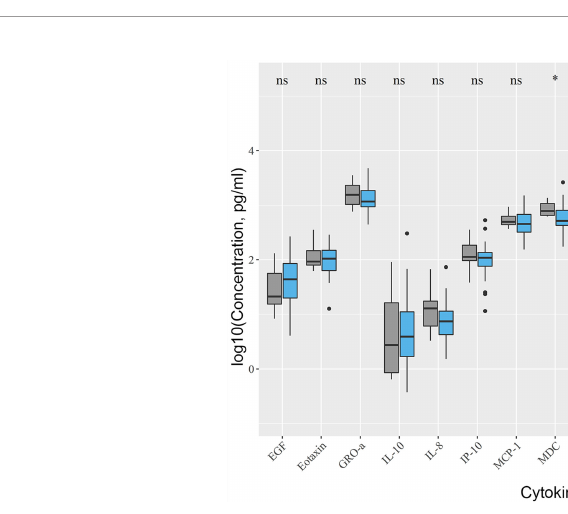
FIGURE 1 | Differences in cytokine levels between STEMI and non-STEMI patients. Non-STEMI patients had elevated levels of MDC, MIP-1 b , TNF- a . Asterix indicates p-adjusted < 0.05. ns, not signi fi